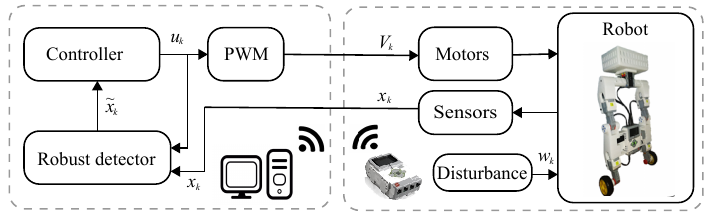
Figure 7. Real-time implementation